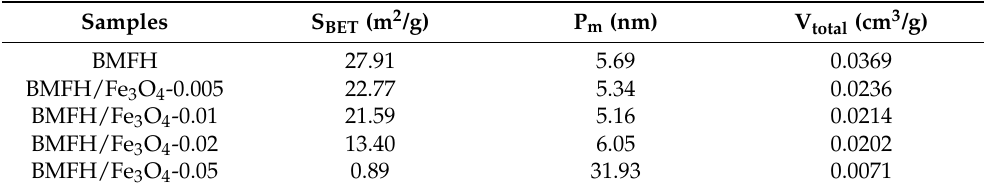
Figure 4. ( A ) N 2 adsorption–desorption isotherms and ( B ) pore size distribution curves of BMFH, BMFH/Fe 3 O 4 -0.005, BMFH/Fe 3 O 4 -0.01, BMFH/Fe 3 O 4 -0.02, and BMFH/Fe 3 O 4 -0.05. Table 1. The data of N 2 adsorption–desorption for BMFH/Fe 3 O 4 prepared under different conditions and BMFH.